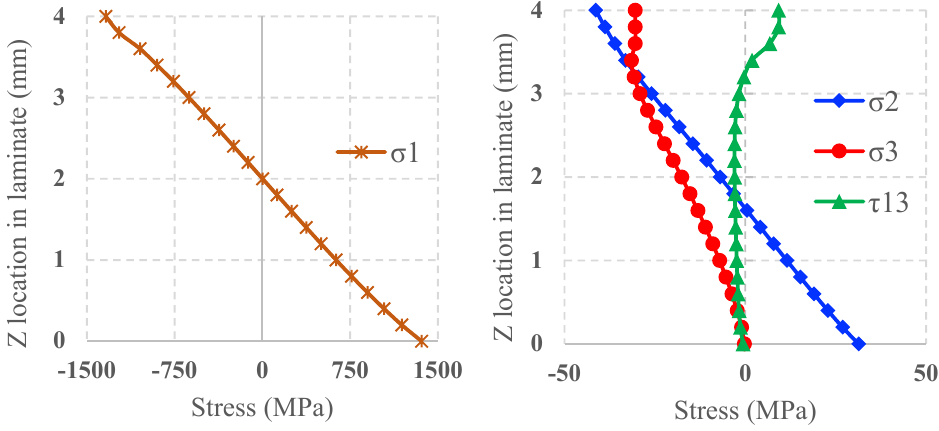
Figure 7. Normal and shear stresses across flexural specimen thickness.